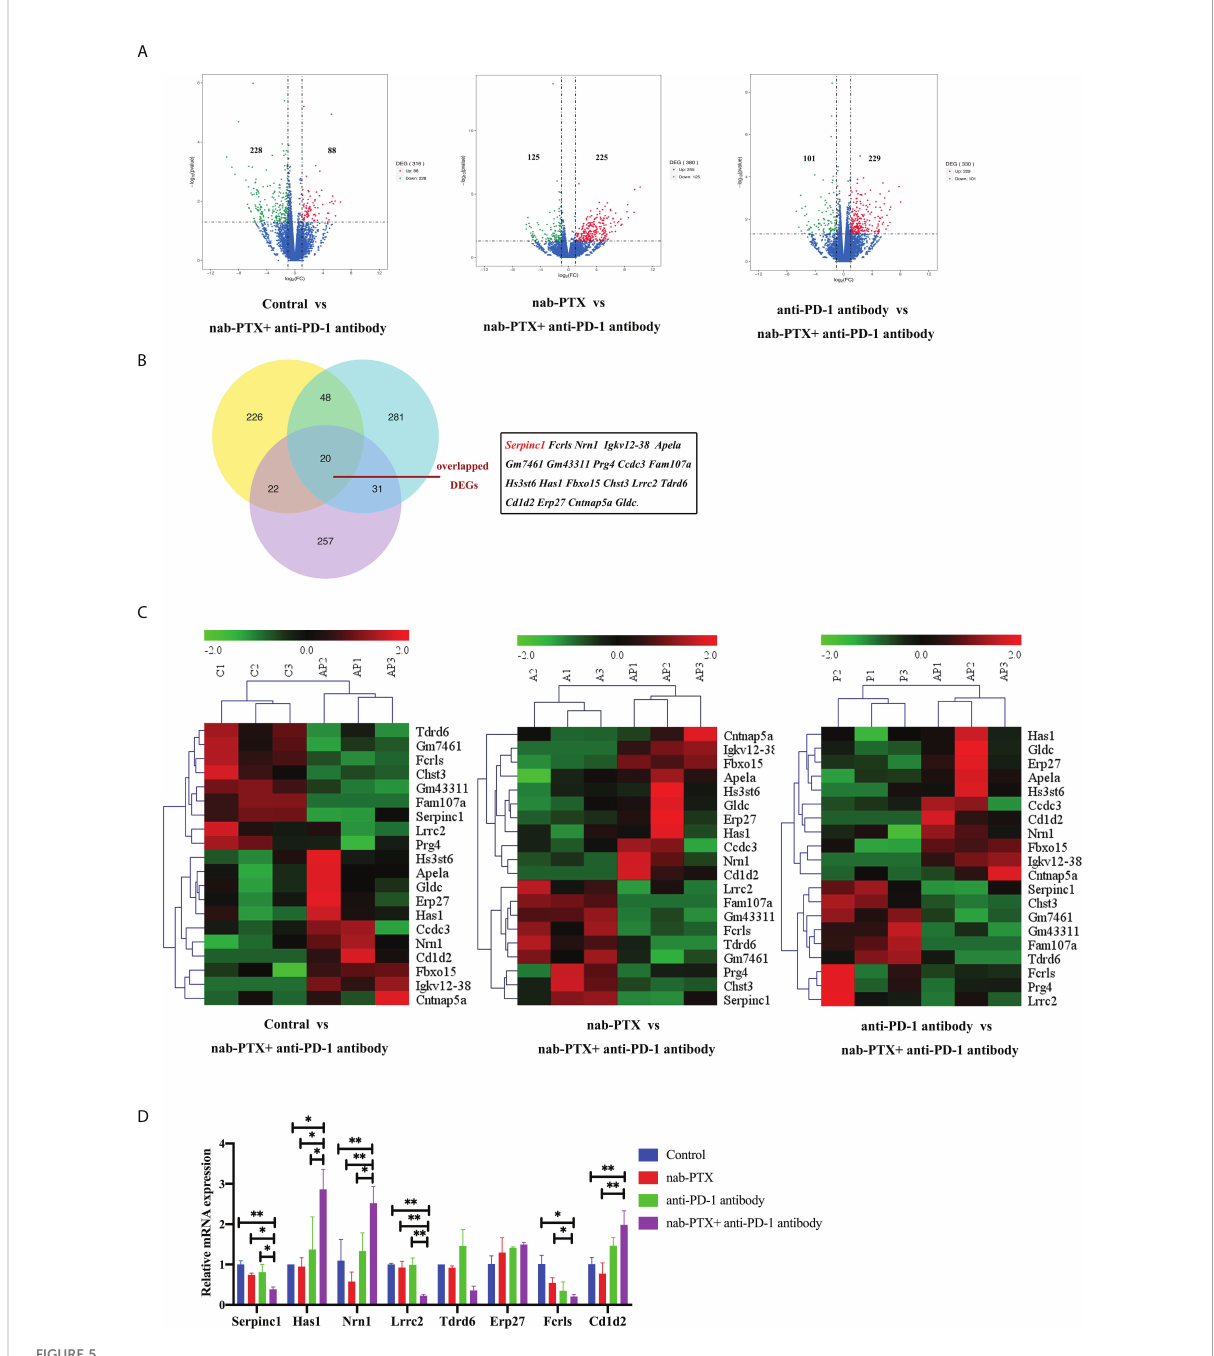
FIGURE 5 Transcriptomic analysis of mRNA in tumor tissues treated with nab-PTX and anti-PD-1 antibody. (A) Volcano plots of differentially expressed genes. Red dots represent upregulated genes, green dots represent downregulated genes, and blue dots represent genes with no signi fi cant changes in expression. (B) Venn diagram shows the 20 co-expressed DEGs among the three comparisons. (C) Gene expression patterns of the overlapped 20 DEGs between every two comparison groups using clustering heatmaps. Red in the heatmap indicates high expression, and green indicates low expression. (D) Validation of partial DEGs by qRT-PCR ( n = 3, biological duplicates), statistically analyzed with two-way ANOVA followed by Tukey ’ s multiple comparisons. * p < 0.05, ** p <